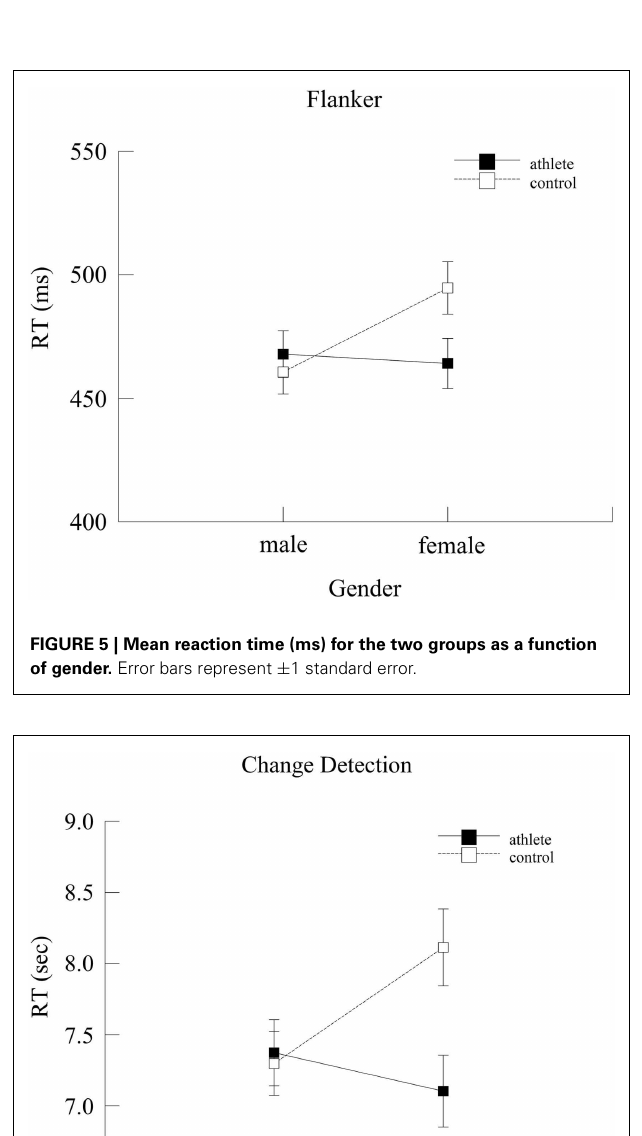
analyses indicated that female athletes (7.10 ± 0.25 ms) were faster ( p < 0.001) than female controls (8.11 ± 0.27 ms), and that